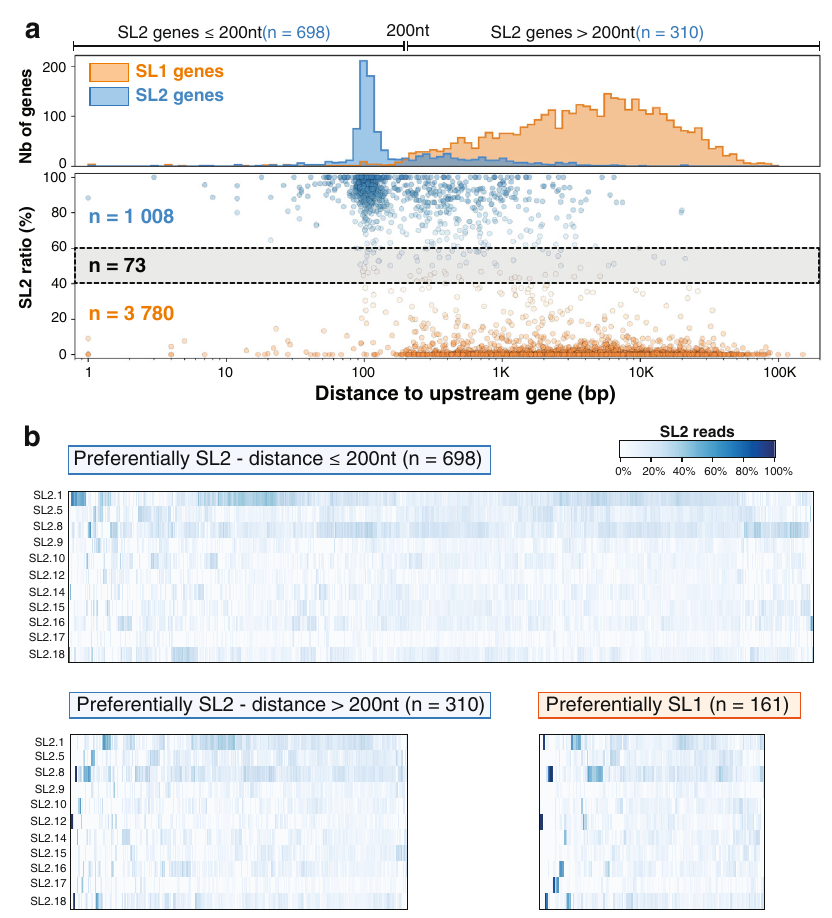
Fig. 3 | Quantitative analysis of SL sequence selectivity. a Bottom: A scatterplot of the ratio of SL2/SL1 reads found against the distance to the closest upstream gene. Positions favored by SL2 (SL2 ratio > 60%) are colored in blue and those by SL1 (SL2 ratio <40%) in orange. Top: Distribution of SL1 and SL2 biased positions con fi rmspreviousobservationsofastrongpreferenceforSL2splicingtooccurata distance of ~100nt downstream from the preceding gene. b Each column of the